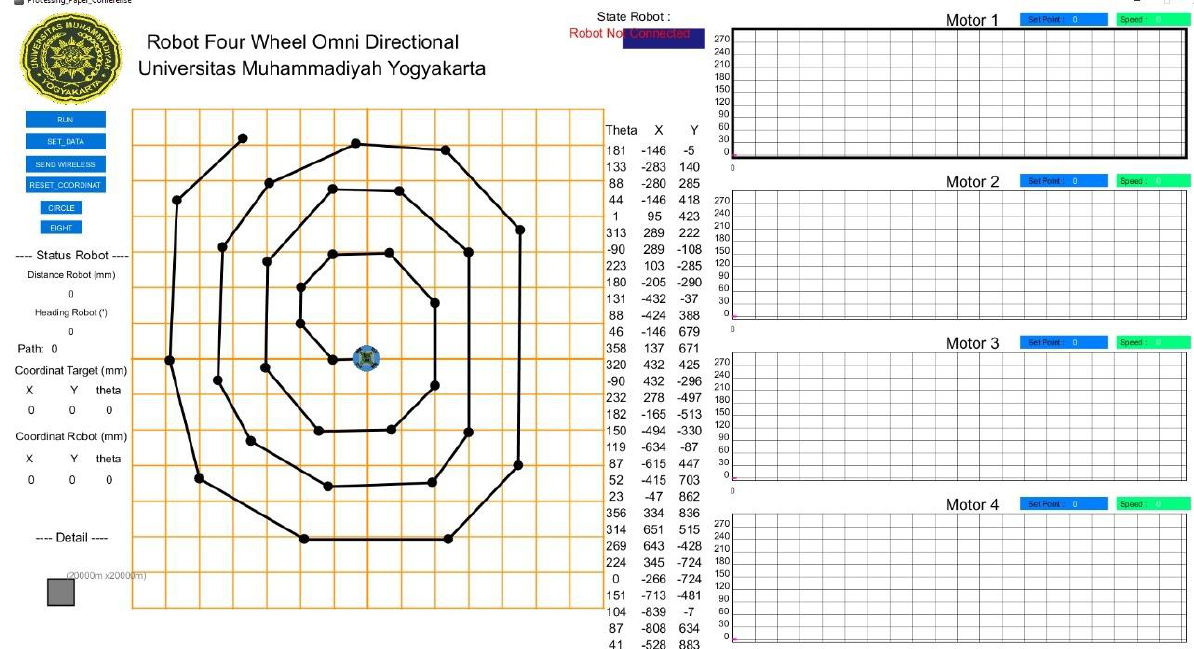
Figure 4. All status of the robot movement will be displayed in the GUI.